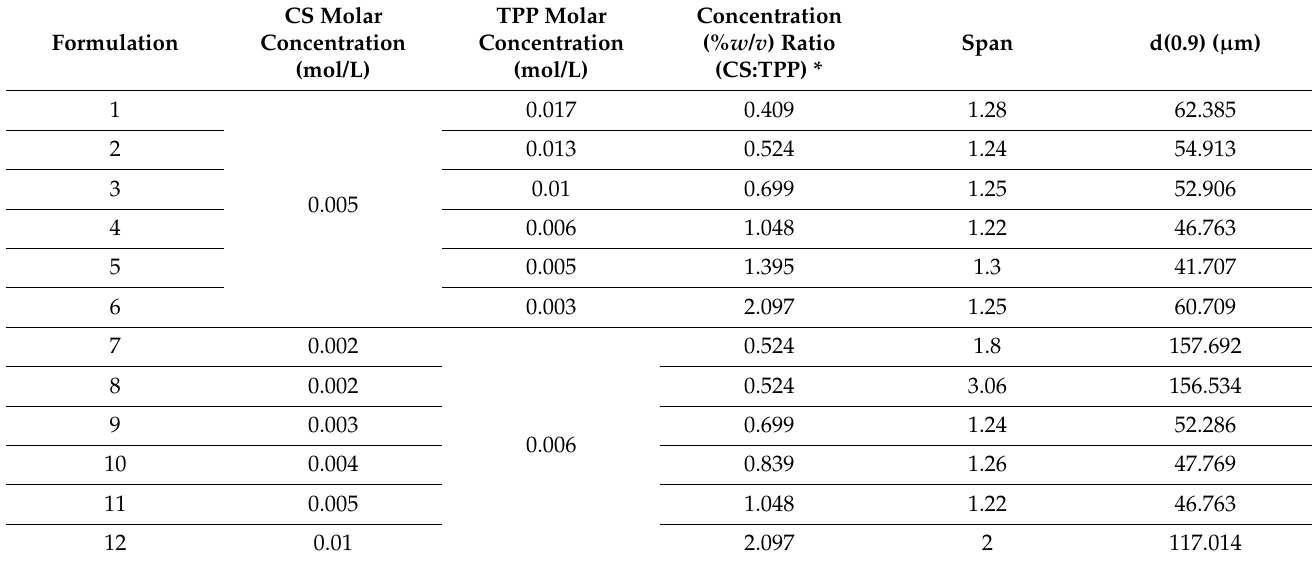
Table 1. Particle size (d(0.9)) and particle size distribution (Span) values obtained for